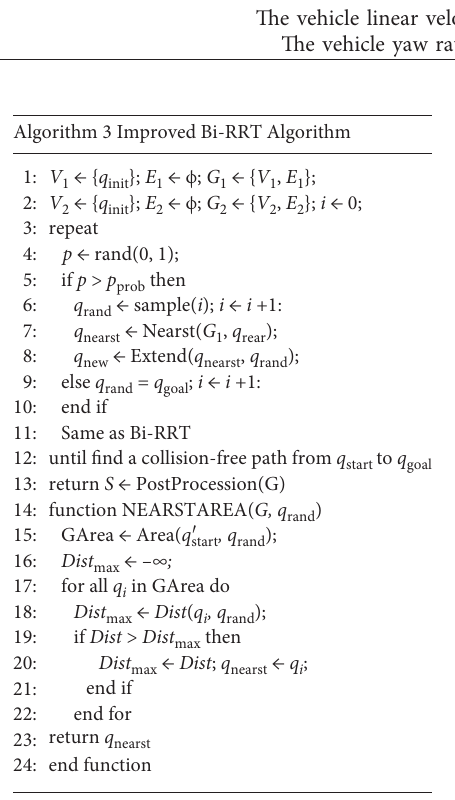
Figure 7: Improved Bi-RRT algorithm.